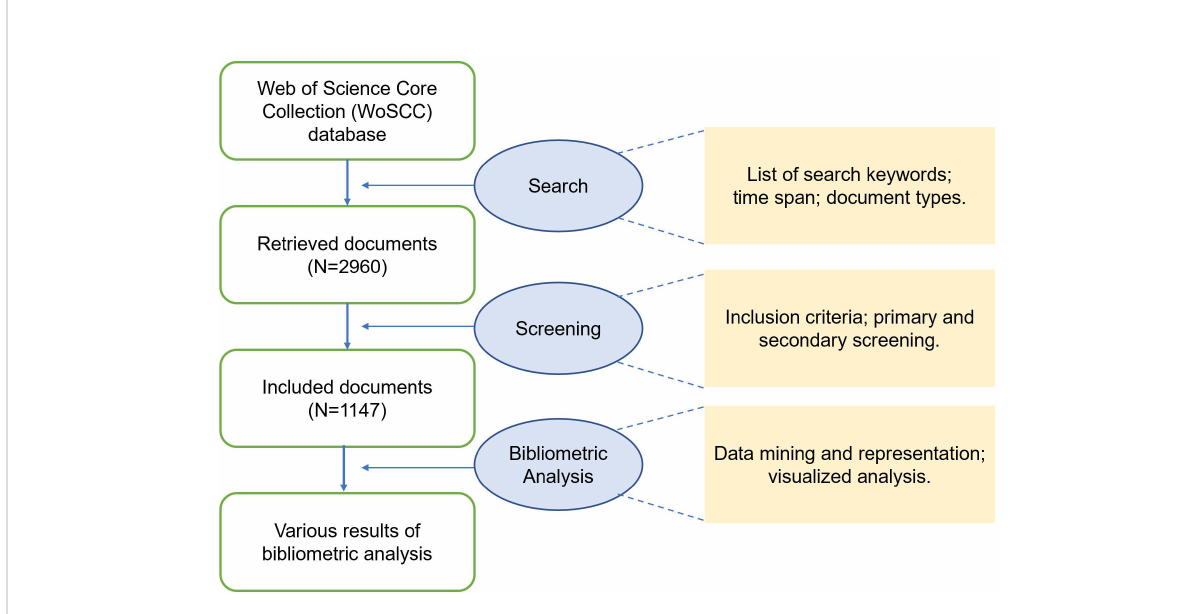
FIGURE 1 Flowchart of search, screening and bibliometric